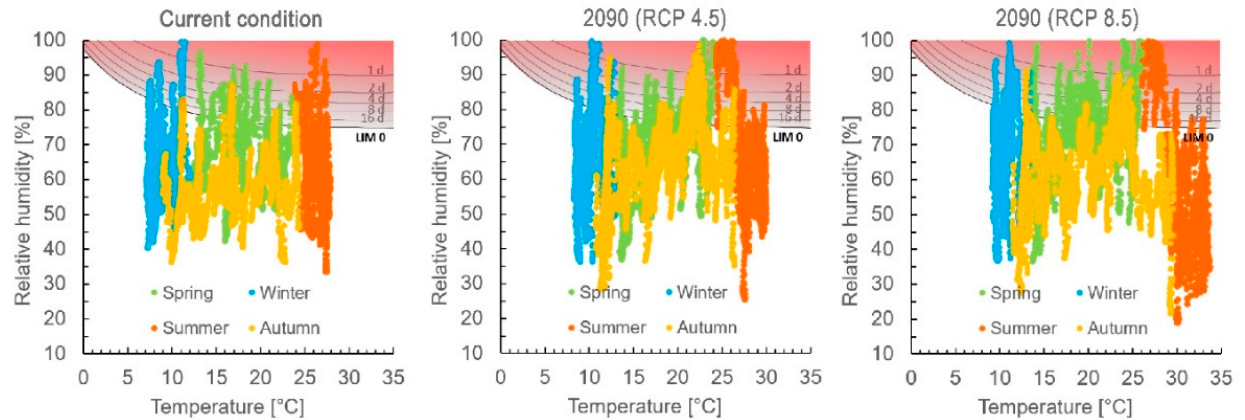
Figure 11. Ts ‐ RH hourly data concerning the mould germination isolines for the analysed scenarios.